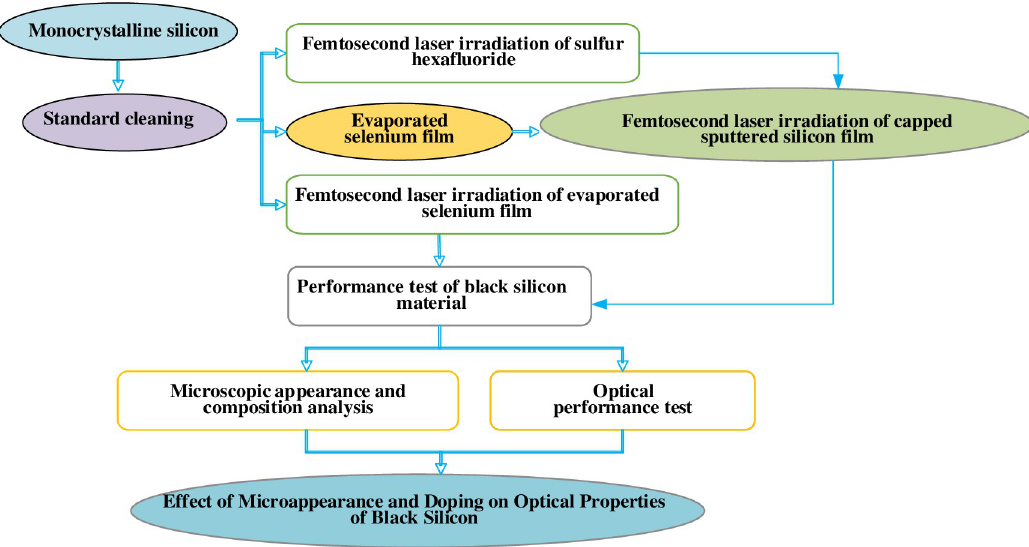
Fig 2. Flow chart of processing doped black silicon material by FS irradiation